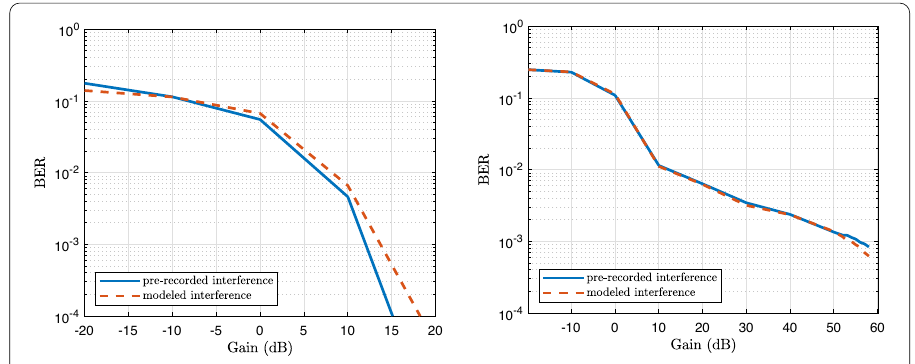
Fig. 18 Spectrum-based model performance. Left: channel 4, right: channel